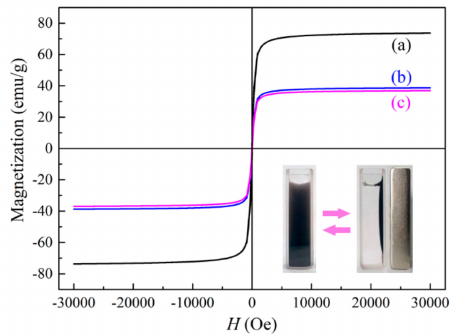
Figure 6. Hysteresis loops of hollow Fe 3 O 4 microspheres ( a ), hollow flower-like Fe 3 O 4 / MnO 2 microspheres ( b ), and hollow flower-like Fe 3 O 4 / MnO 2 / Mn 3 O 4 photocatalyst ( c